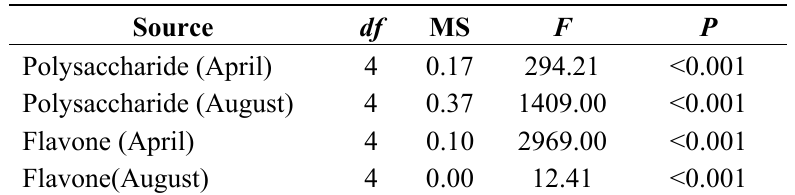
Table 1. ANOVA analysis of total flavonoids and polysaccharide under different cultivation conditions (common-garden and light-controlled